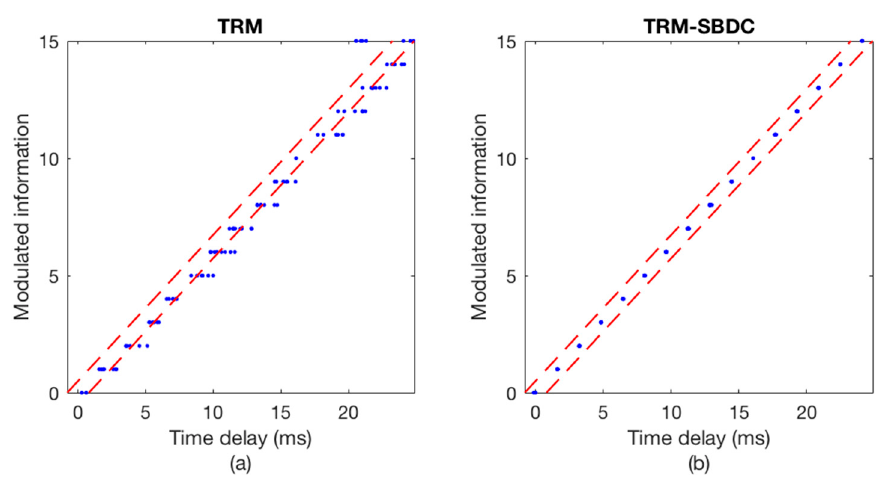
Figure 16. The decoding results when the sending boat is drifting. ( a ) TRM; ( b ) TRM-SBDC. Table 4. The decoding results of different experimental scenes. Experimental